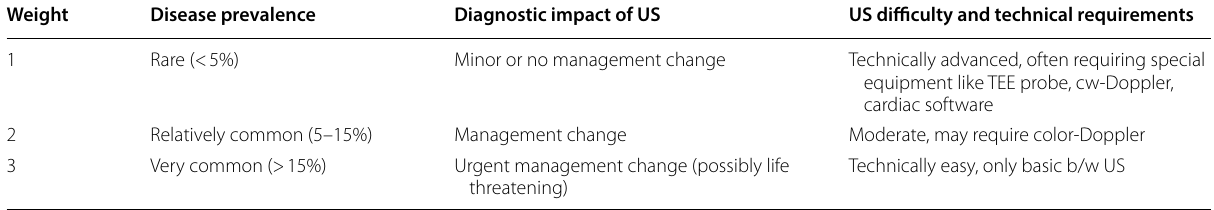
Table 1 Weighting of prevalence, diagnostic impact and difficulty of POCUS applications